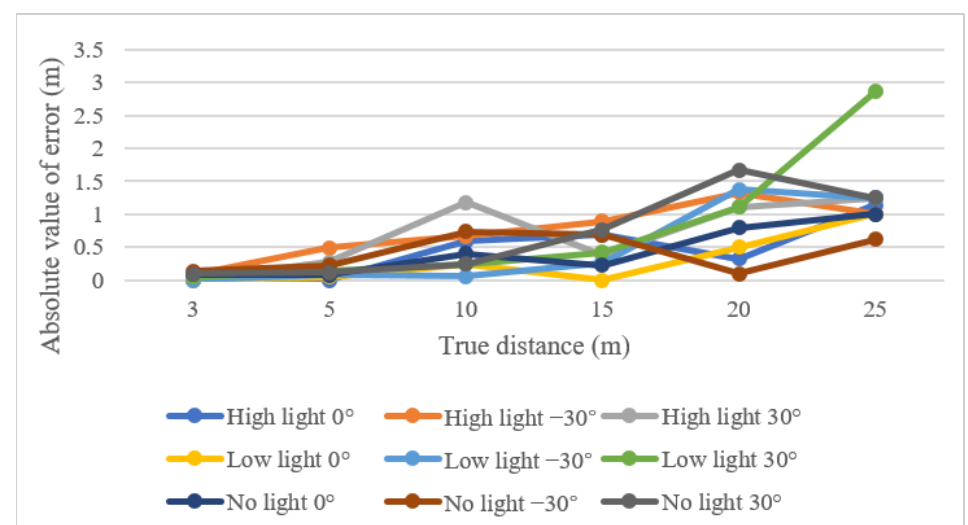
Figure 7. Measured distance under different lighting and orientations. ( a – c ) 0°, −30°, and 30° under high-light condition; ( d – f ) 0°, −30°, and 30° under low-light condition; ( g – i ) 0°, −30°, and 30° under no-light condition.